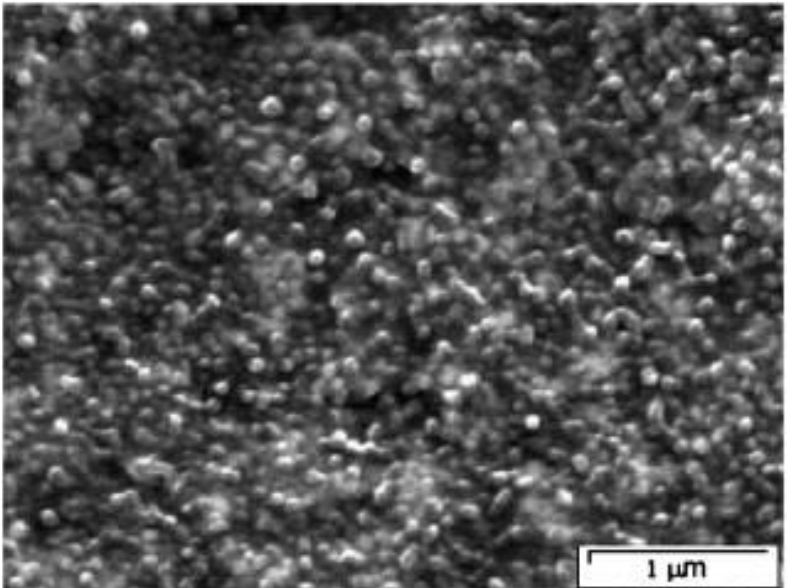
Figure 7. SEM of a SPEK membrane modified with 22 wt.% TiO 2 . Reprinted with permission from [72]. Copyright (2002) Elsevier Science B.V.